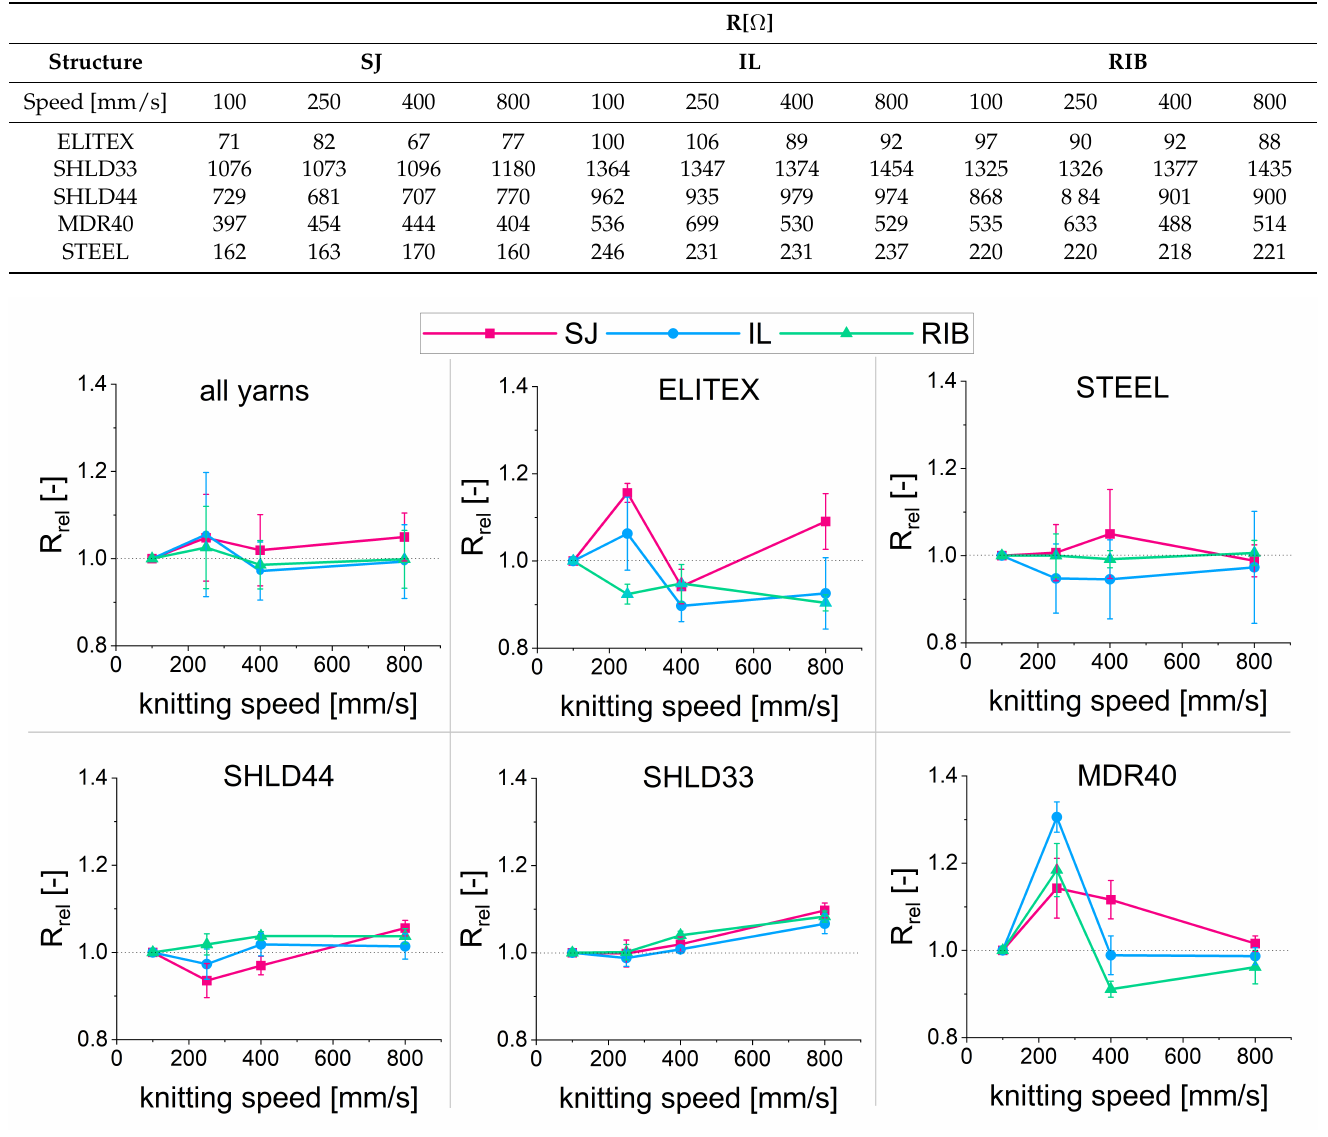
Table 4. Mean resistance of the knitted tracks for all combinations after knitting.